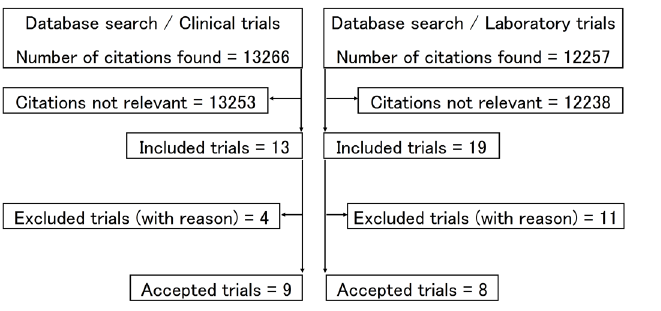
Fig 1. Flow diagram of trial